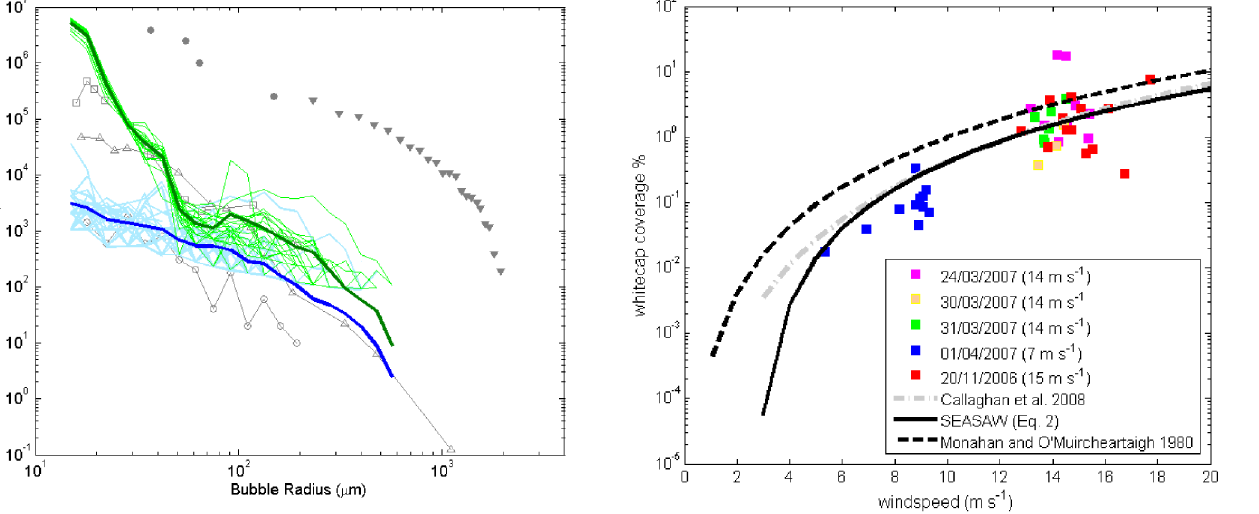
Fig. 6. The mean bubble size spectra (solid lines) for 1 April (7ms − 1 winds, blue) and 31 March (14ms − 1 winds, green) and all individual measurements from those deployments (pale blue and pale green). Open ocean and surf zone spectra in grey are as in Fig. 5.